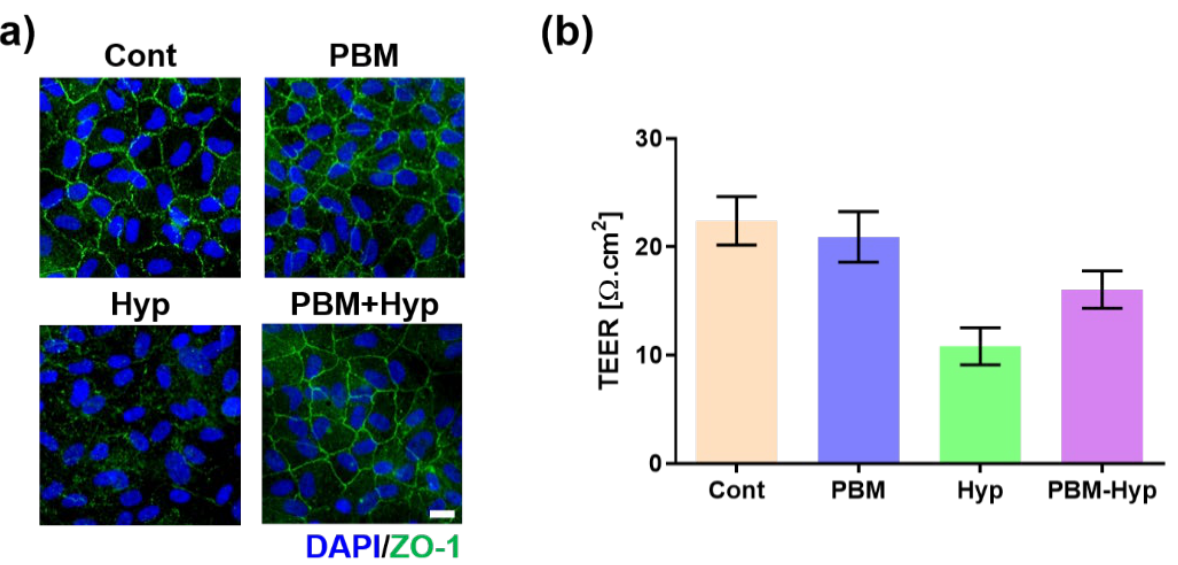
Figure 2. Effect of PBM on barrier function. ( a ) Immunofluorescence image of ZO-1. ( b ) TEER value. Scale: 20 μm. Cont: control model, PBM: PBM-treated model, Hyp: hypoxia model, PBM+Hyp: hy- poxia model with pre-treatment with PBM. n = 3.